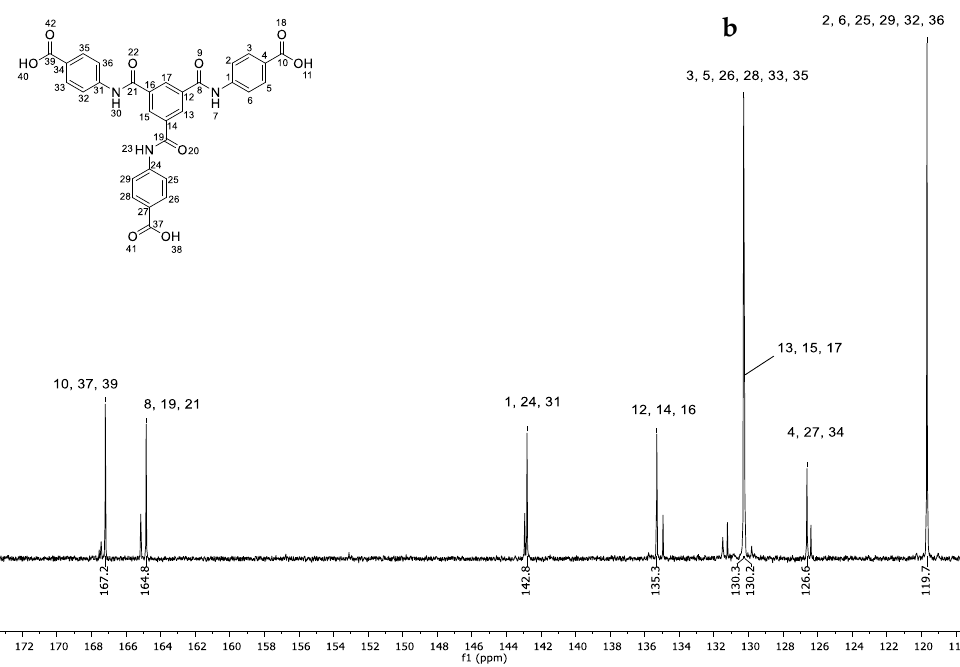
Figure 2 . ( a ) 1 H NMR spectrum and ( b ) 13 C NMR spectrum of ligand 3 . Figure 2. ( a ) 1 H NMR spectrum and ( b ) 13 C NMR spectrum of ligand 3